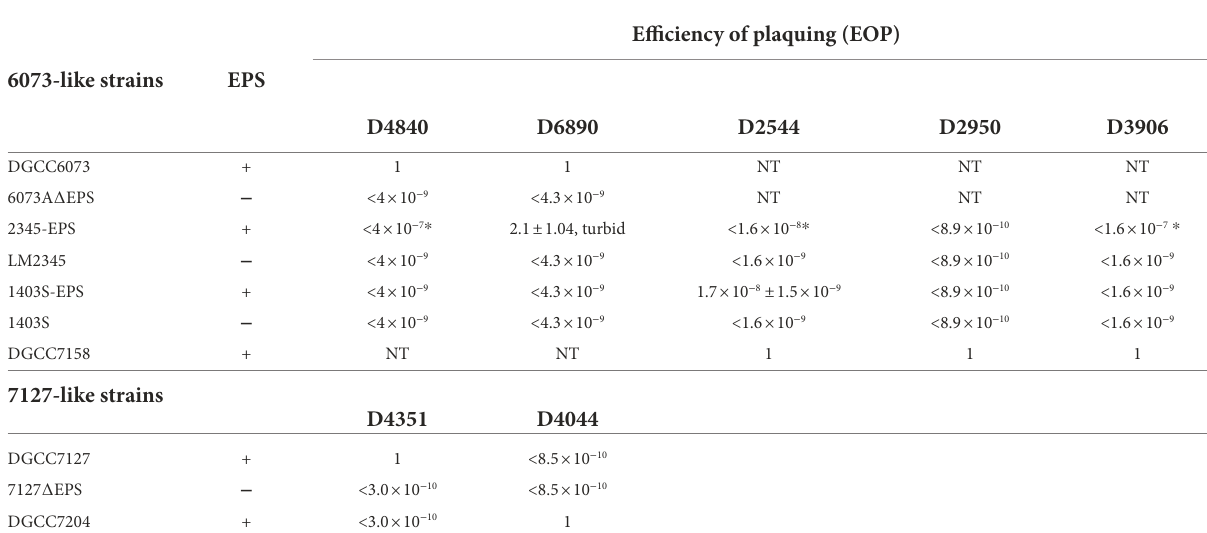
TABLE 2 Phage plaque